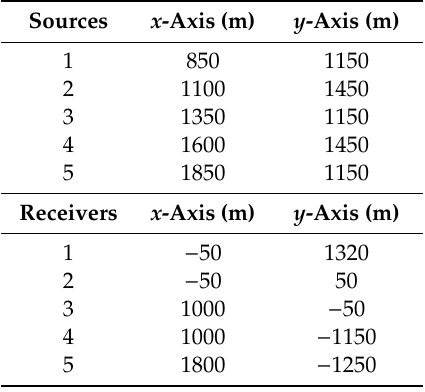
Table 3. Sources and receivers’ coordinates for the Llumeres